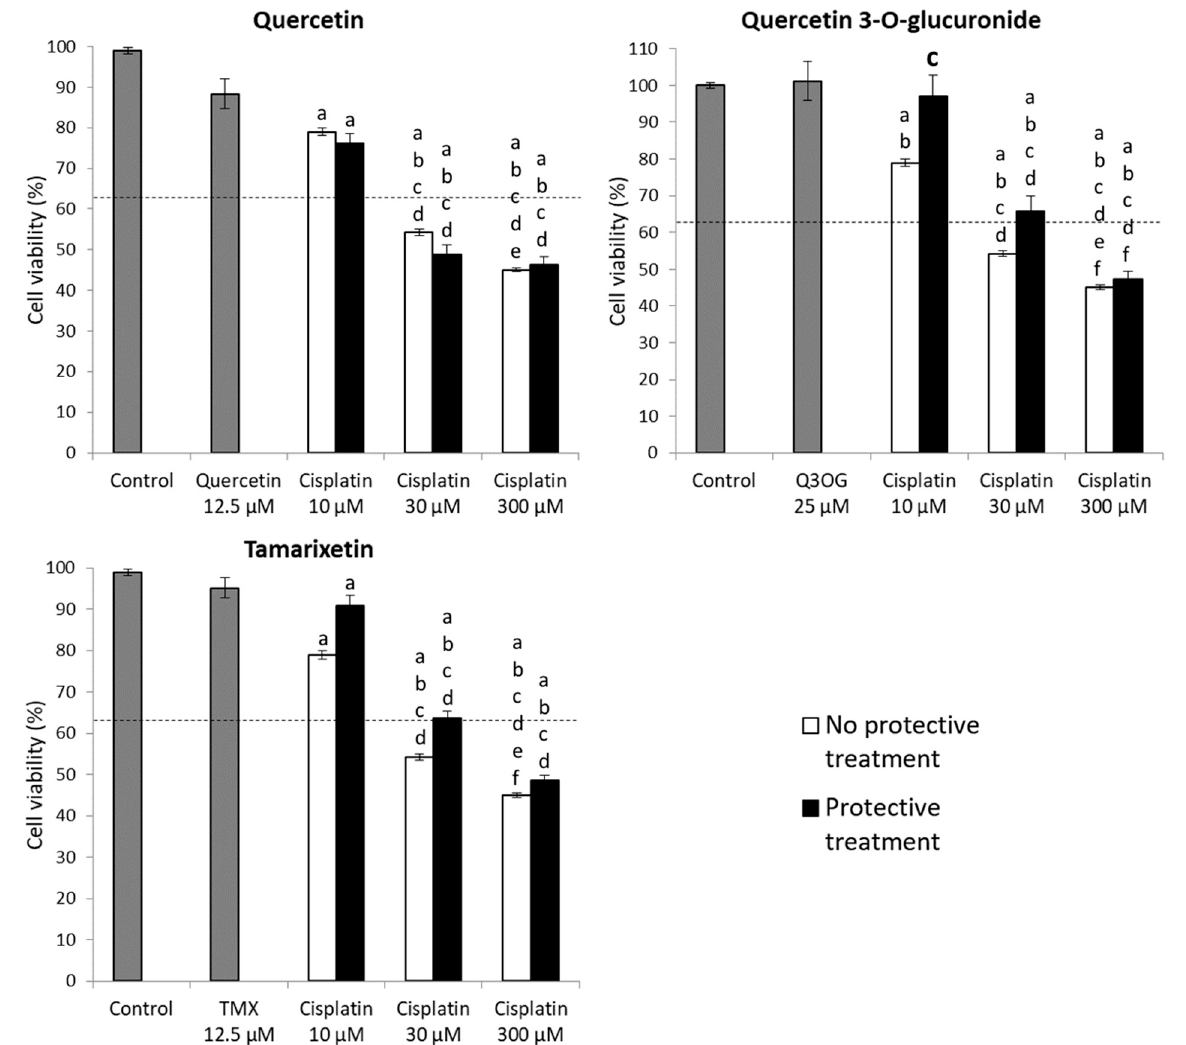
Figure 4. Quercetin, quercetin 3- O -glucuronide and tamarixetin efficacy assays in HK-2 cells for 24 h against cisplatin cytotoxicity. The cells were pretreated 6 h with the corresponding metabolite and subsequently cotreated for 18 h with the metabolite and cisplatin 10, 30 and 300 μ M, respectively. The MTT technique was used to estimate cell viability. Values are expressed as the mean ± SEM. Significant differences ( p < 0.05): a vs. Control; b vs. Metabolite alone (quercetin, quercetin 3- O -glucuronide or tamarixetin); c vs. 10 µ M cisplatin; d vs. cisplatin 10 µ M +